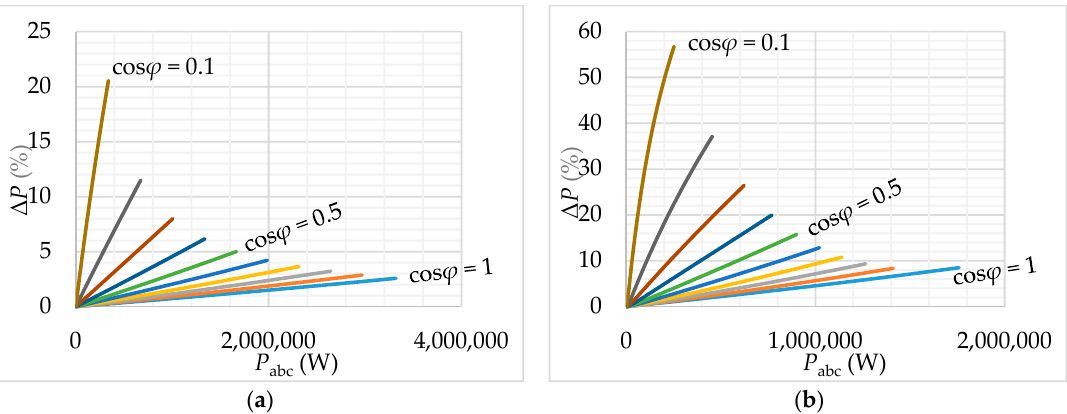
Figure 12. The dependence of increasing APLs from three-phase active power consumption for ACSR 42/7: ( a ) the length of 5 km; ( b ) the length of 30 km.